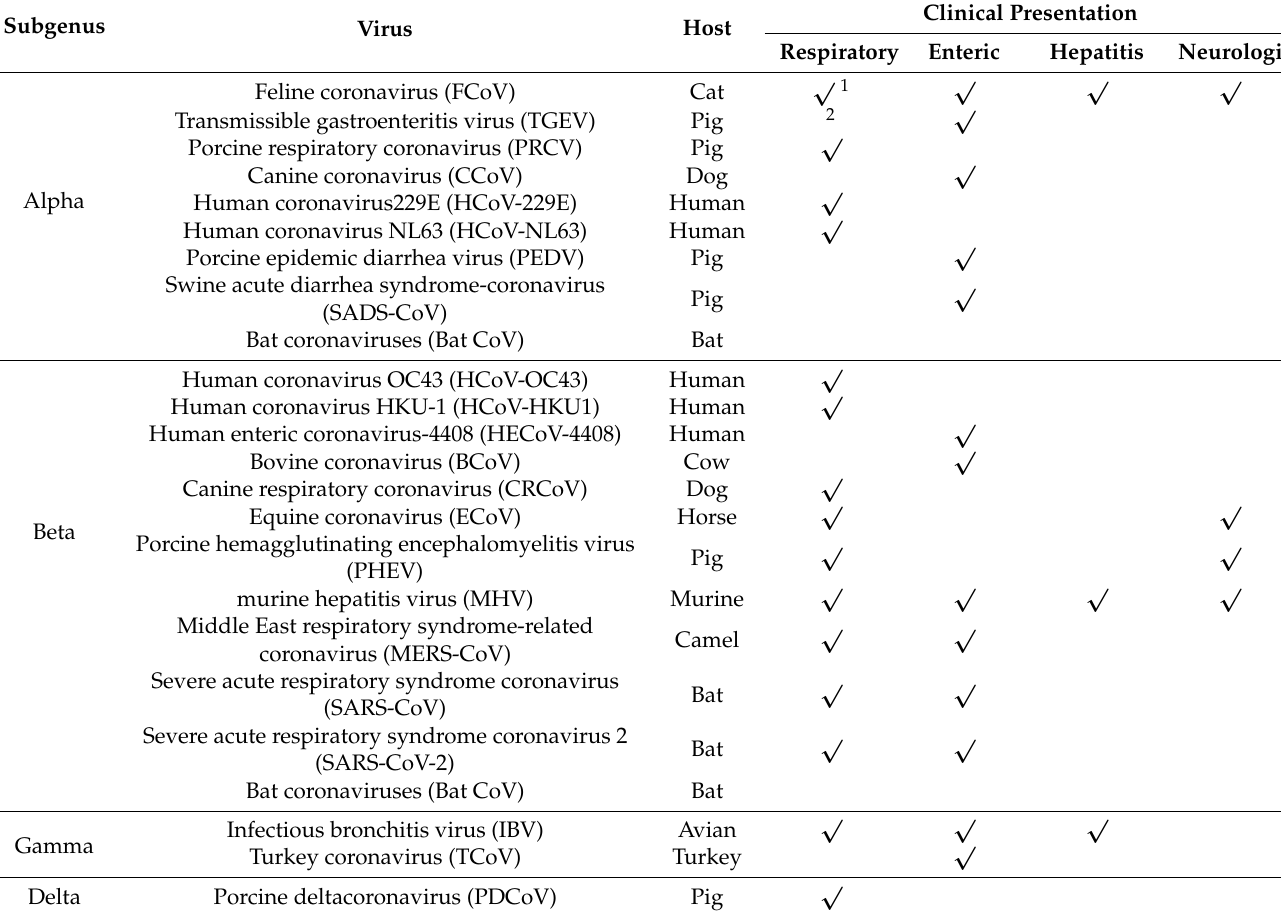
Delta Porcine deltacoronavirus